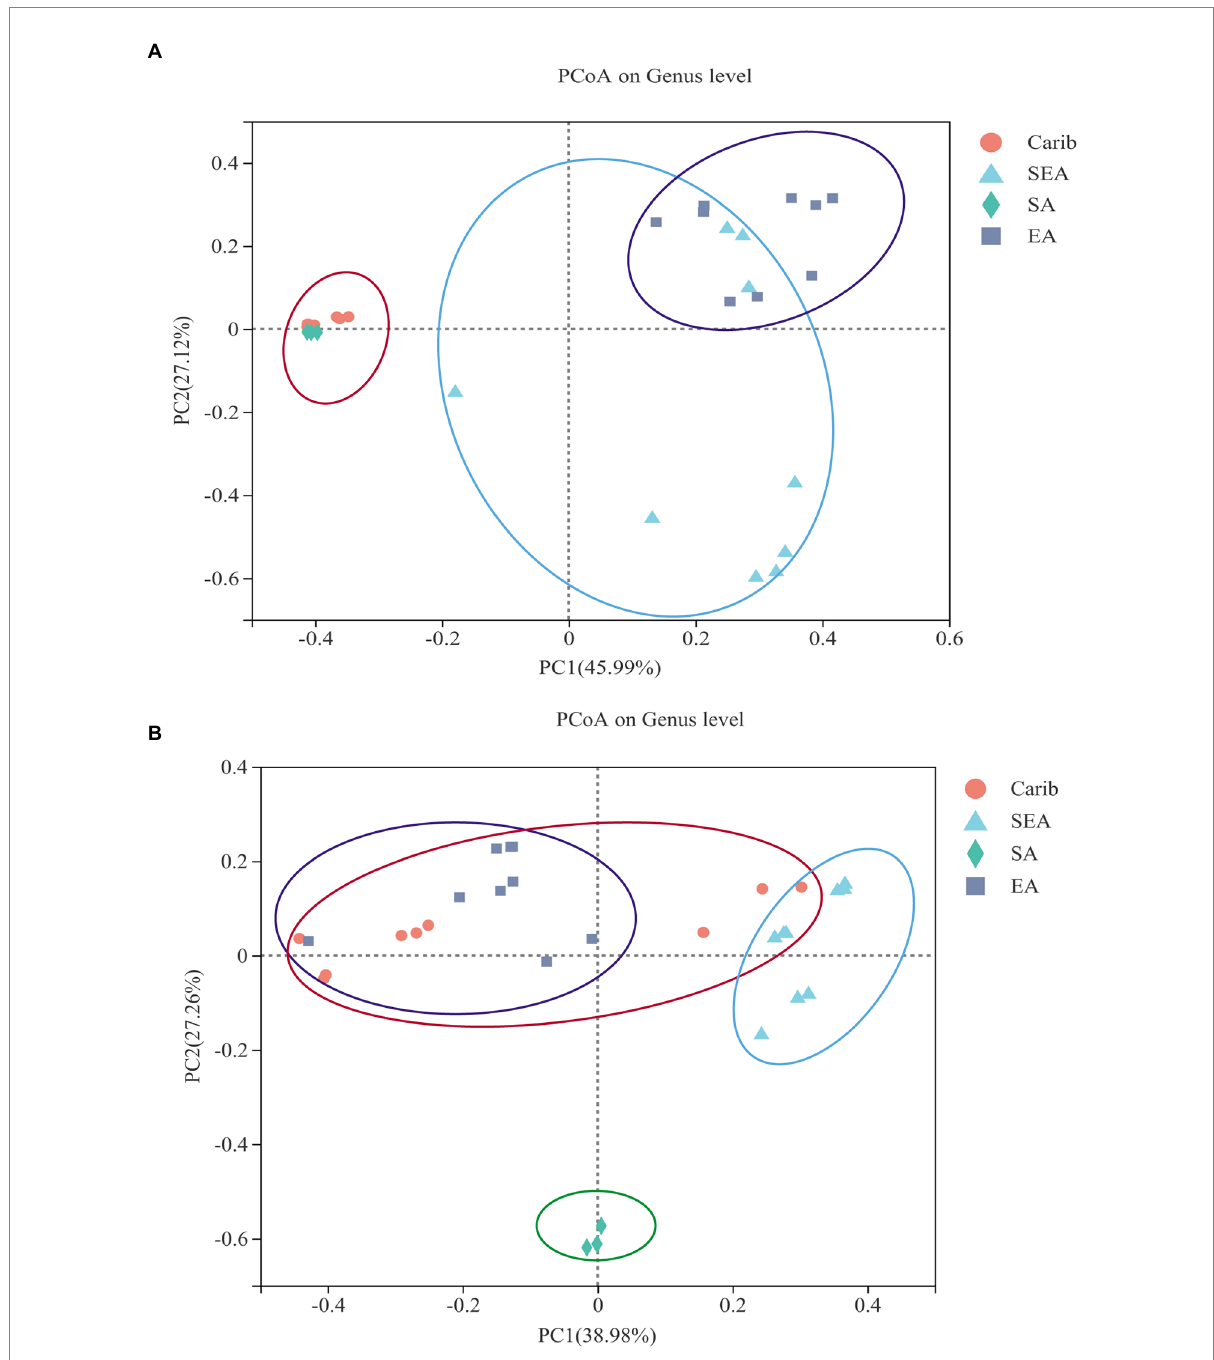
FIGURE 4 Principal co-ordinates analysis on genus level with cigar bacteria (A) and fungus (B)